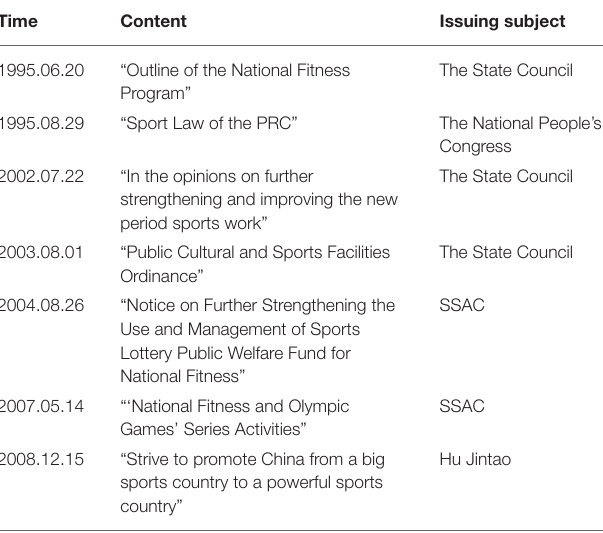
TABLE 1 | Relevant contents of the full start-up stage of national fitness.